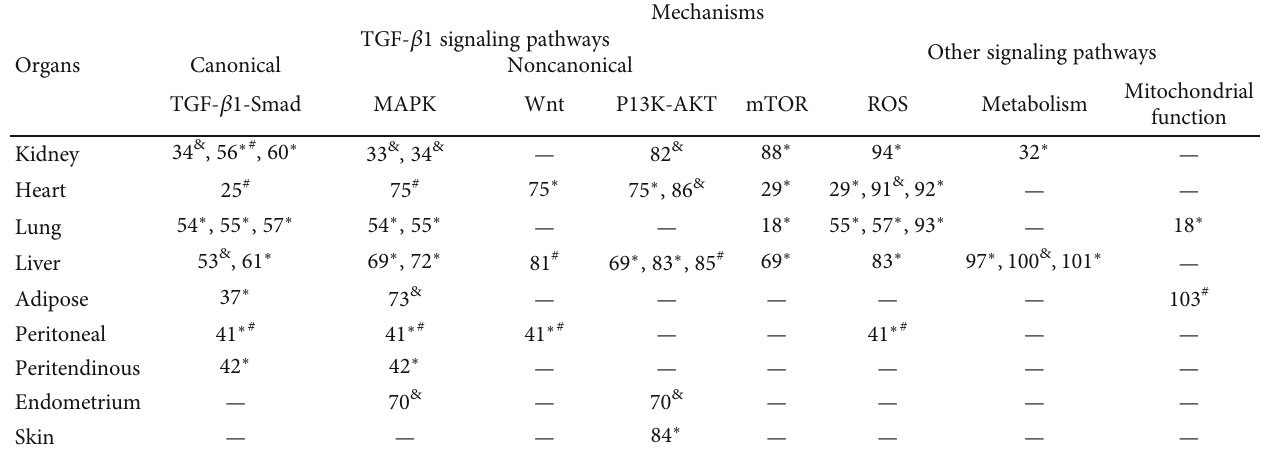
Table 1: We use di ff erent symbols to indicate the di ff erent role of AMPK in these studies. AMPK-dependent mechanisms are identi fi ed by ∗ , AMPK-independent mechanisms are identi fi ed by # , and the studies which did not research the role of AMPK are identi fi ed by & .